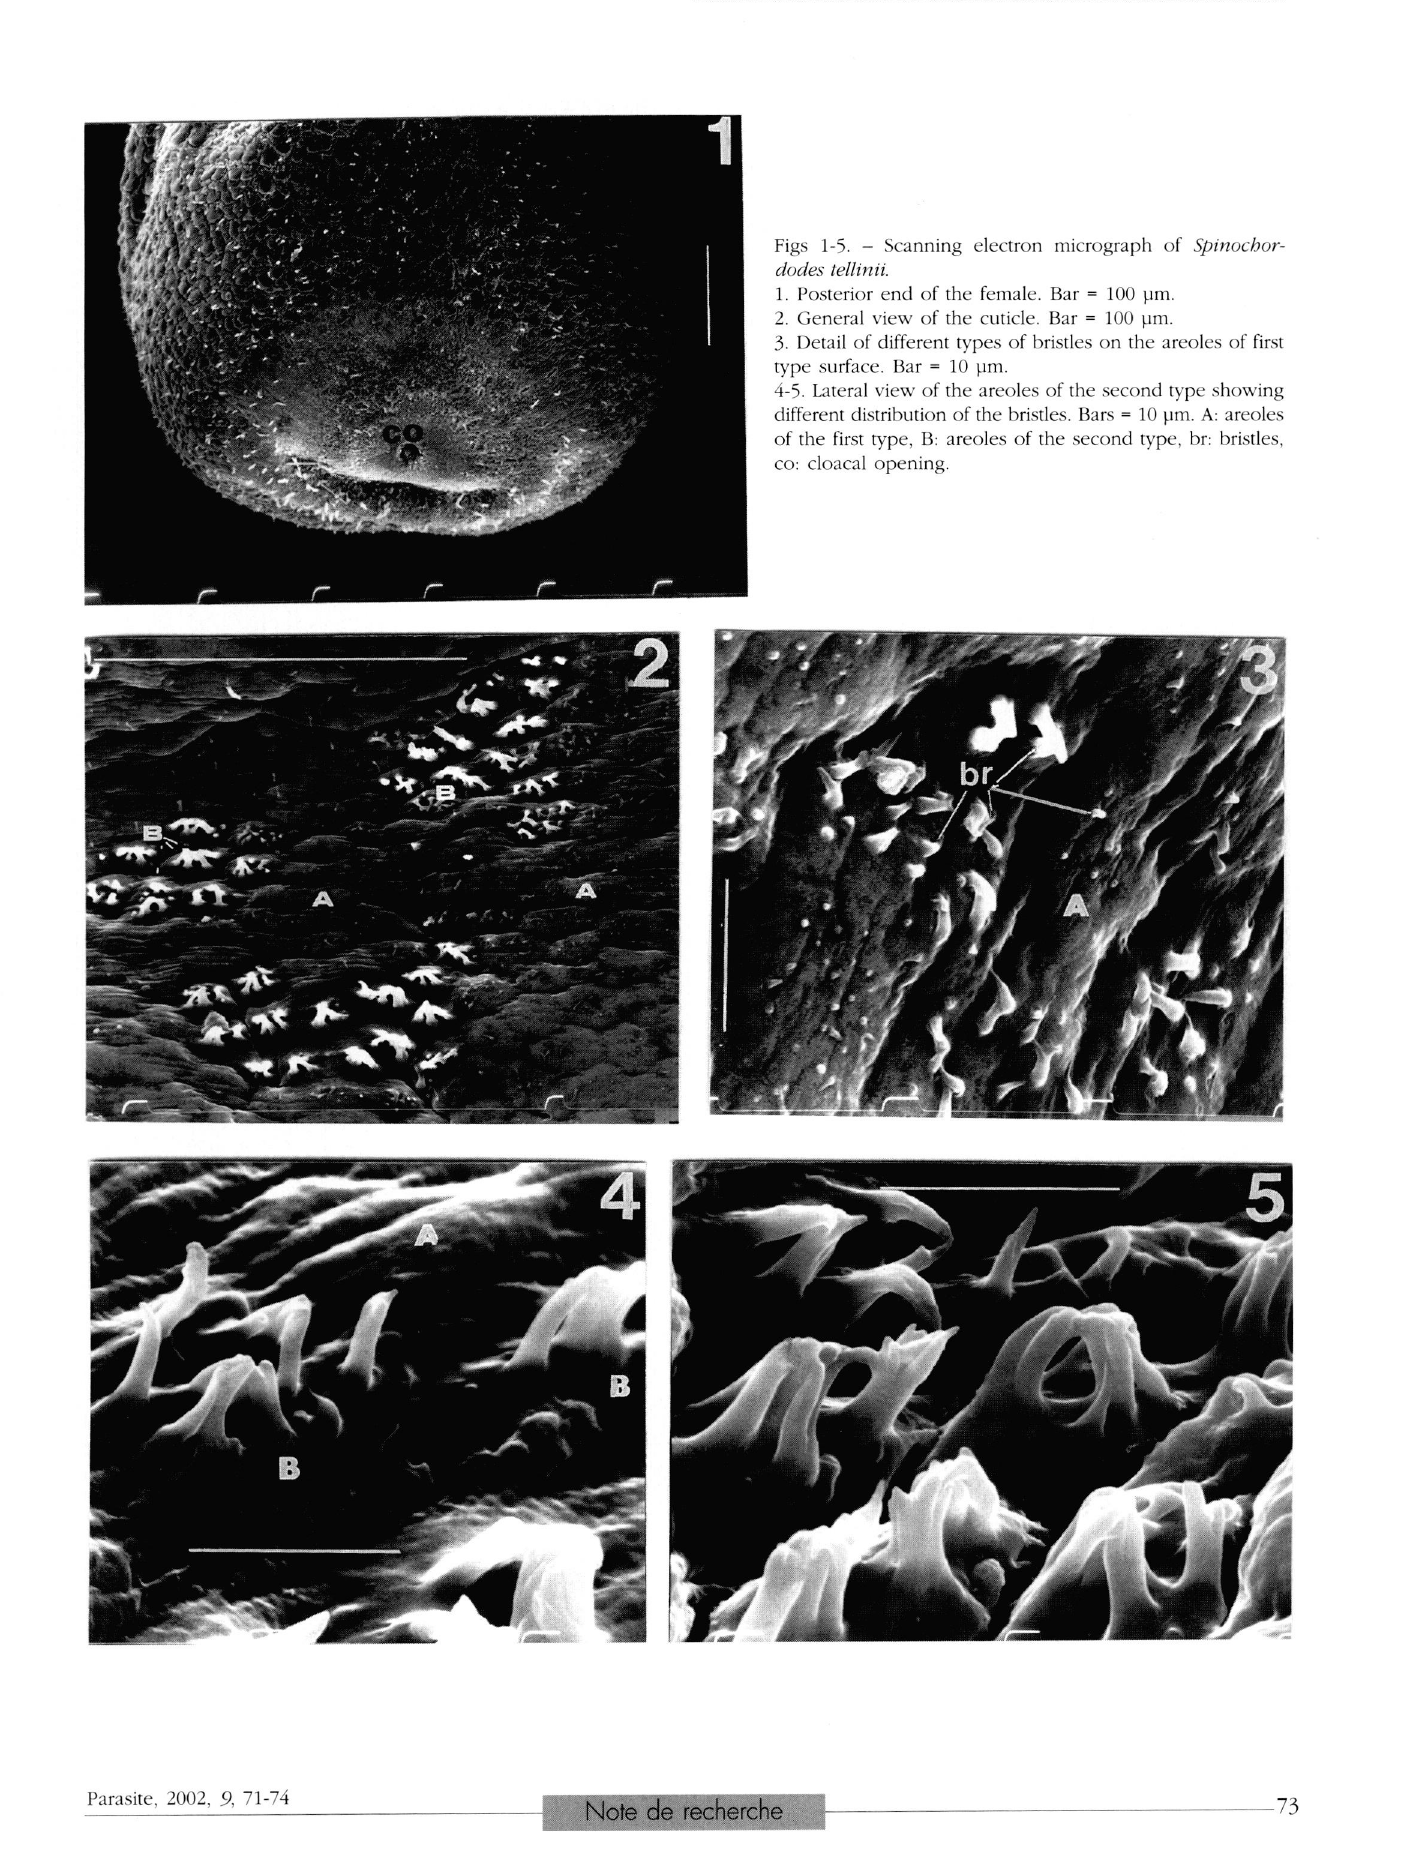
Figs 1-5. - Scanning electron micrograph of Spinochor­ dodes